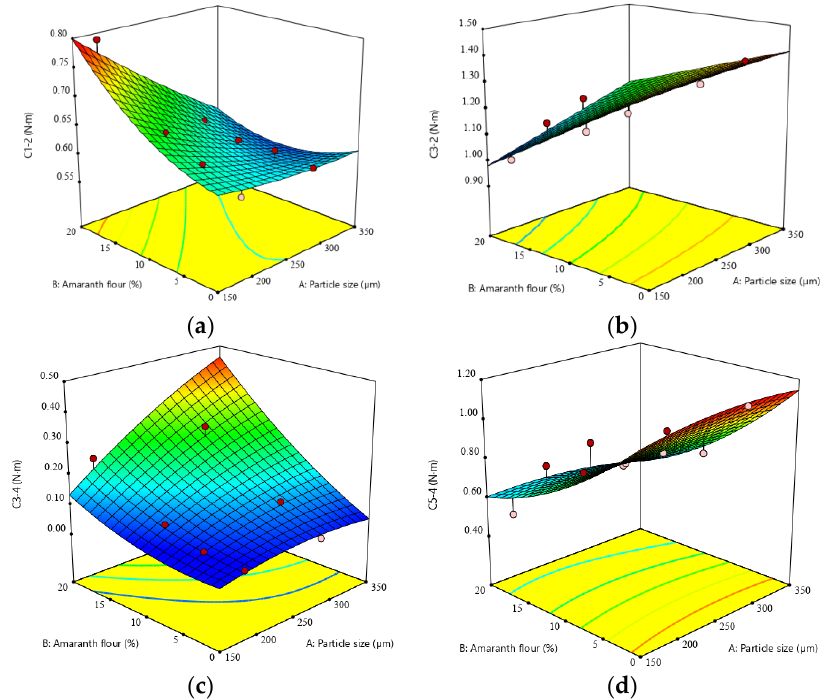
Figure 2. Three-dimensional response surface plots showing the interaction between amaranth flour particle size and addition level on: ( a ) protein weakening (C1-2; ( b ) starch gelatinization (C3-2); ( c ) the stability of hot starch gel (C3-4); and ( d ) starch retrogradation (C5-4). The effects of factors on dough extension properties are presented in Figure 3. It can be seen from Table 3 that dough tenacity was significantly ( p < 0.05) affected by the AF addition level, while particle size showed a non-significant effect ( p ˃ 0.05) on this param- eter. It can be observed in Figure 3a that when the AF amount was increased, the dough tenacity was also increased. At the same time, when the dough tenacity increased with AF addition, the dough extensibility decreased significantly ( p < 0.05) with an increase in this factor. The quadratic term of AF influences in a positive way the extensibility (Figure 3b). The quadratic regression model was fitted for the dough strength, which indicates that this alveograph parameter was significantly ( p < 0.05) influenced by the linear and quad- ratic term of the AF addition level. It can be observed in Figure 3c that when the AF amount increased, the dough strength decreased. The alveograph configuration ratio pre- sented a significant ( p < 0.05) increase only with AF addition level increase (Figure 3d).